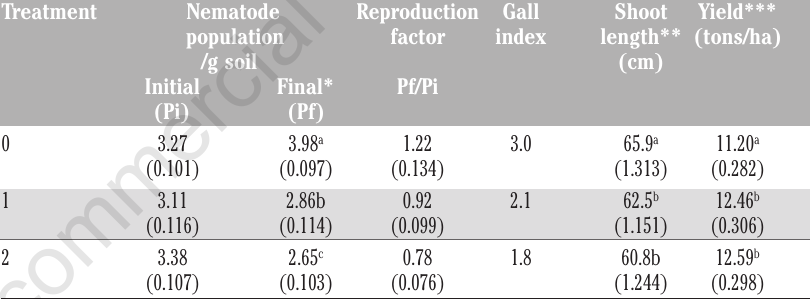
Table 3. Effect of foliar application of SA on plant resistance against root-knot nematode M. incognita , root-galling, plant growth and yield of tomato (average of five replications).